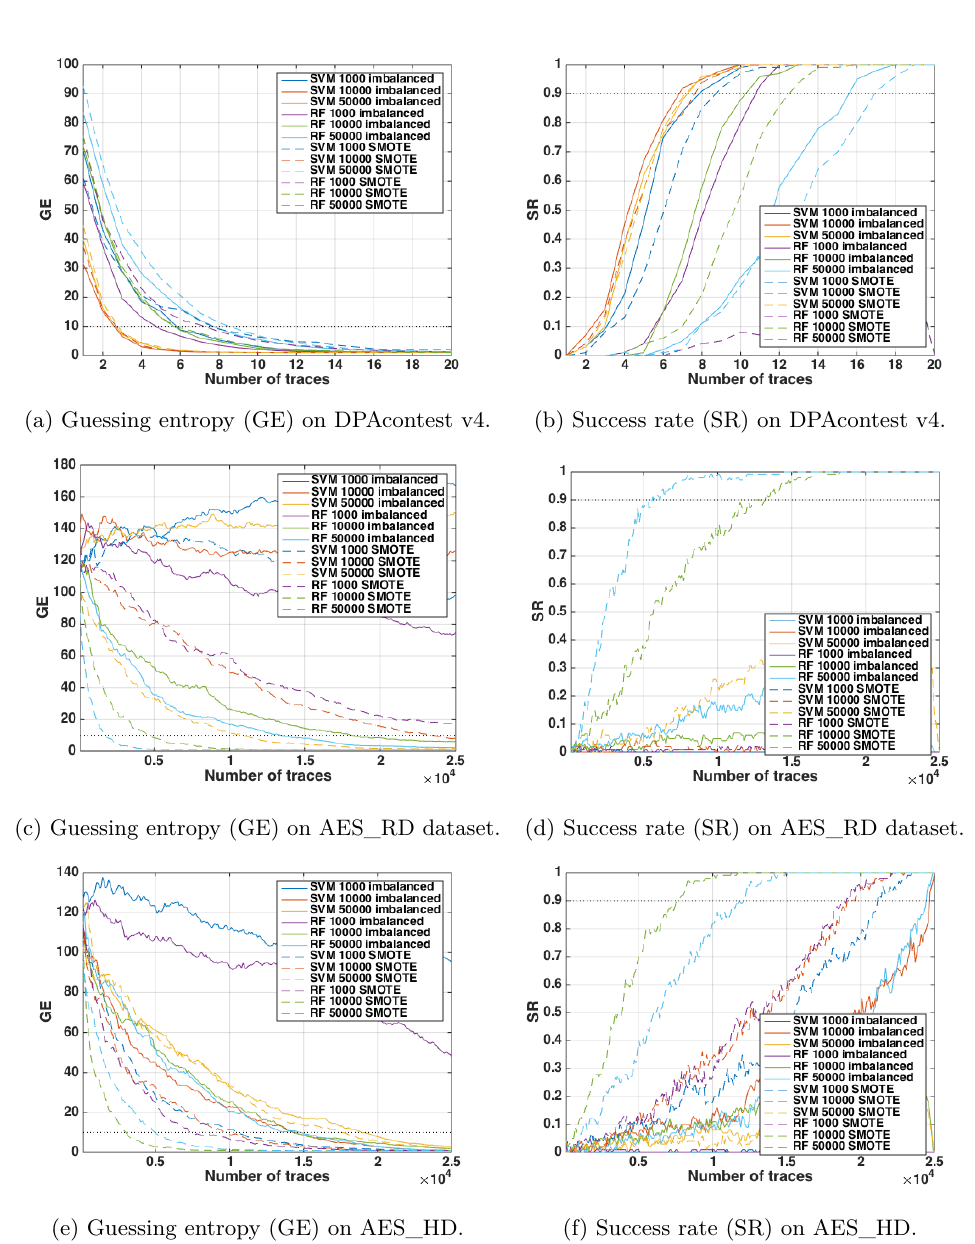
Figure 2: Guessing entropy and success rate for imbalanced and SMOTE on all three